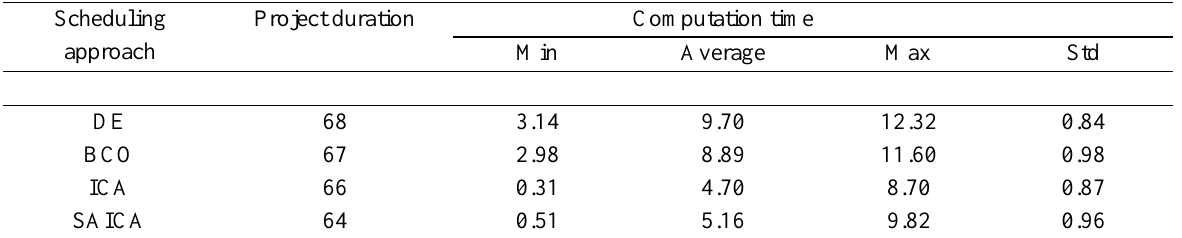
Table 7. The statistic results of project duration and CPU time in 30